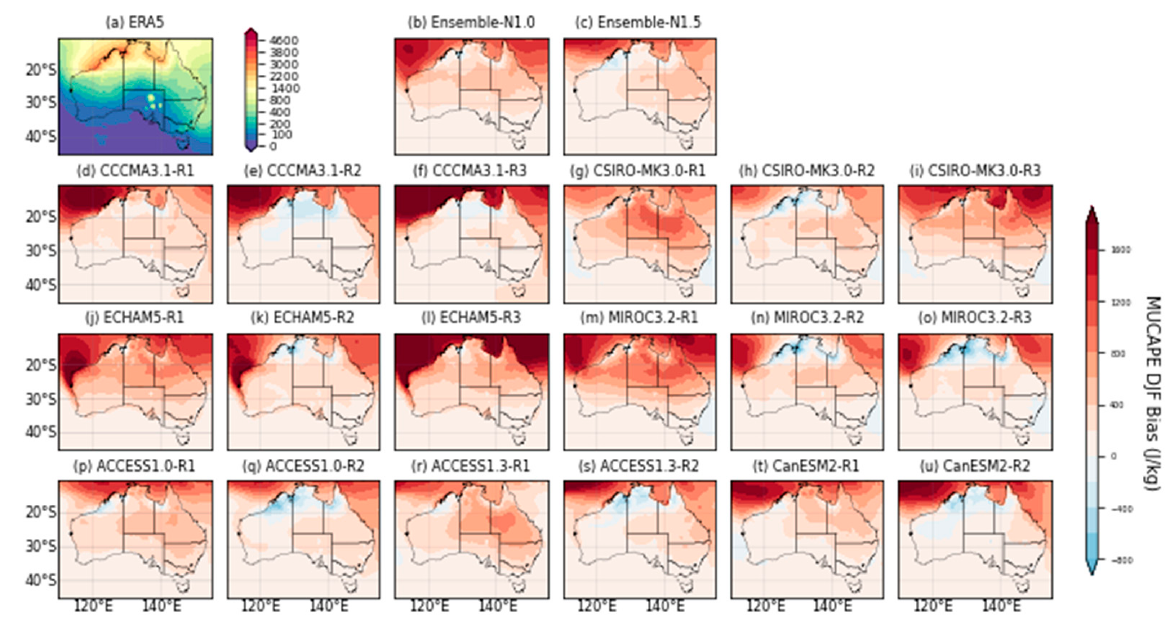
Figure A25. As in Figure A21 except for MUCAPE. Unit: J kg − 1 .